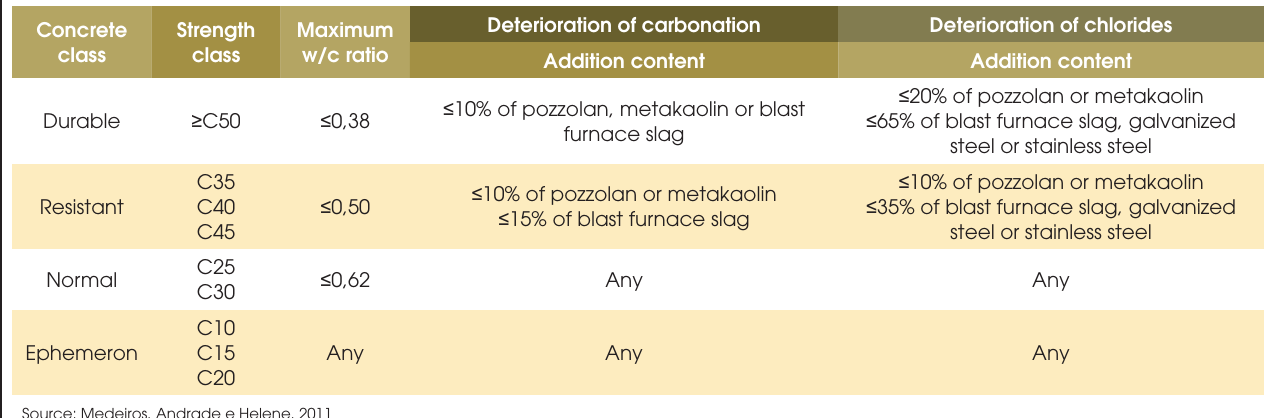
Table 11 – Classification of concrete strength against the risk of reinforcement corrosion Concrete